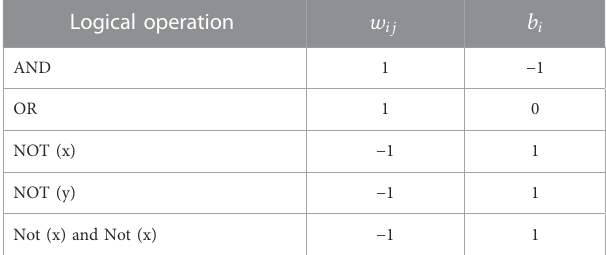
implementation. Logical